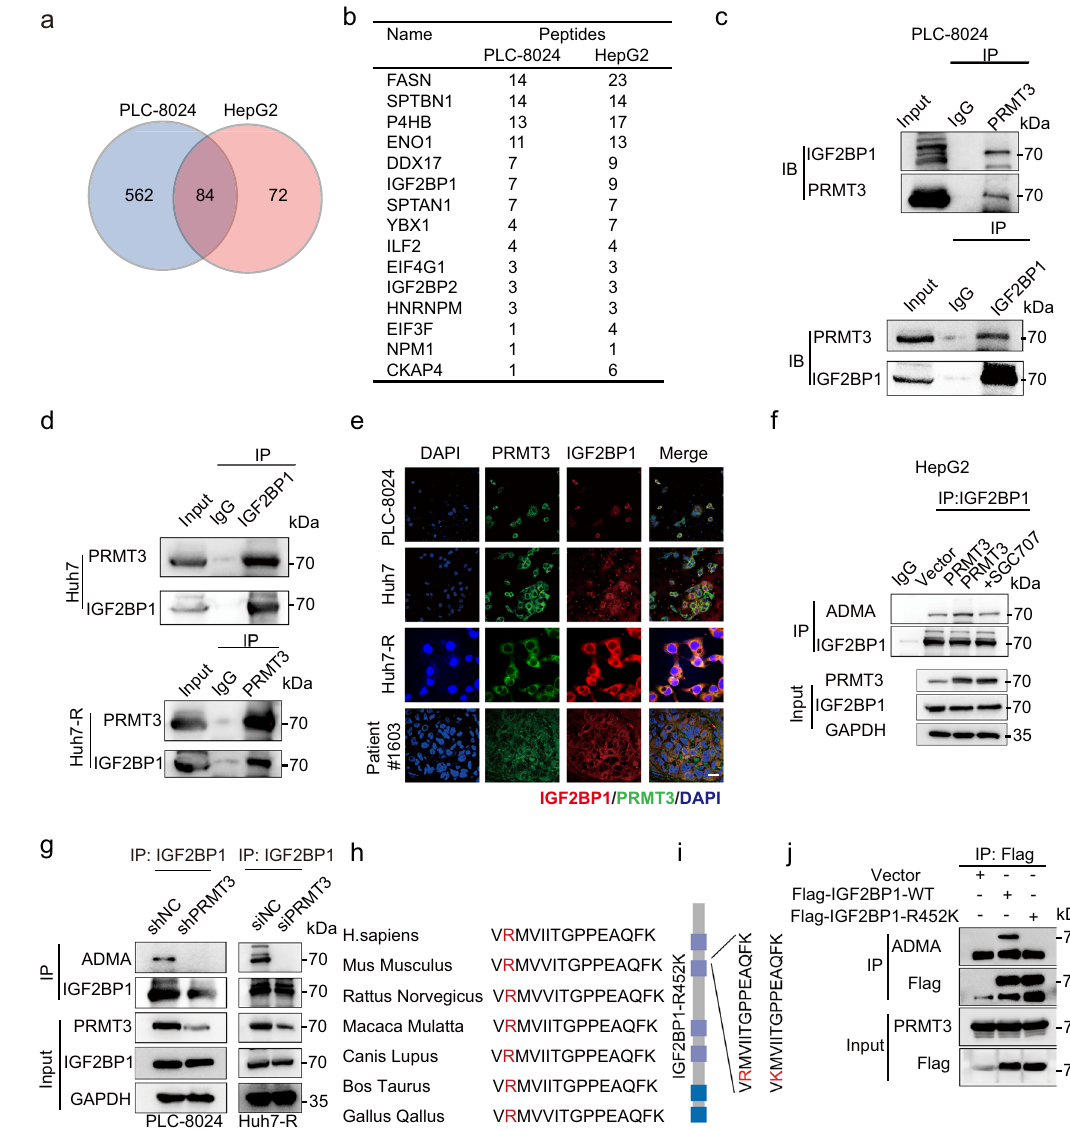
Fig. 3 | PRMT3 methylates IGF2BP1 at R452. a Venn Diagram showing the 84 common proteins pulled down by PRMT3in PLC-8024 and HepG2cells which were analyzedbyliquidchromatography/tandemmassspectrometry(LC – MS/MS). b The number of peptide fragments (95% CI) of proteins pulled down by PRMT3 in PLC- 8024cellsandHepG2cellsidenti fi edfromtheIP-MSanalysis. c WBanalysisshowed that endogenous PRMT3 and IGF2BP1 interact with each other in PLC-8024 cells using reciprocal co-immunoprecipitation. d WB analysis showed that endogenous IGF2BP1 pulled down endogenous PRMT3 in Huh7 cells, and endogenous PRMT3 pulled down endogenous IGF2BP1 in Huh7-R cells. e Immuno fl uorescence staining showed the co-localization of PRMT3 (green) and IGF2BP1 (red) in HCC cells and HCC patient samples. Scale bar, 50 μ m. f WB analysis of immunoprecipitated